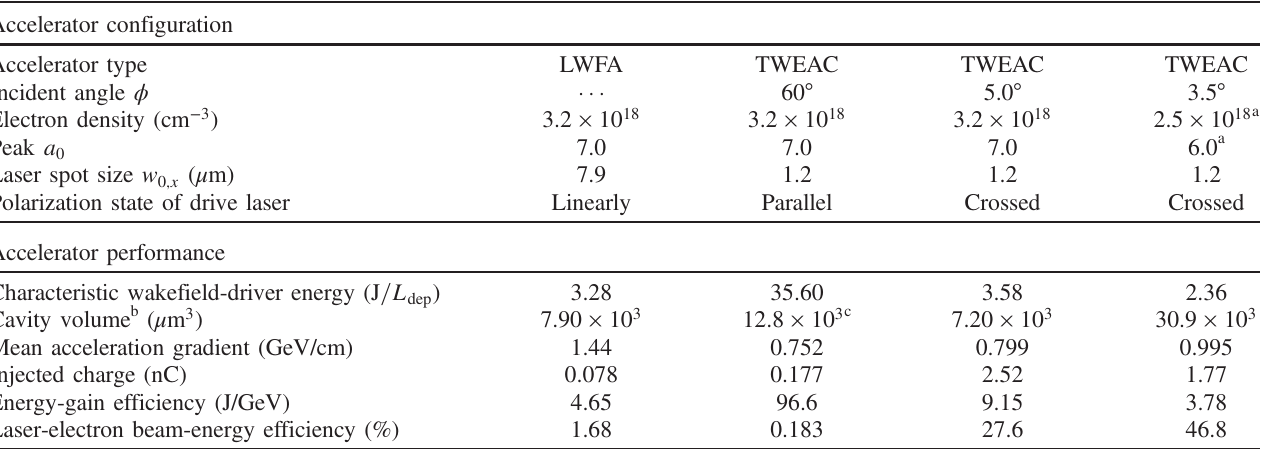
TABLE I. Comparison of various performance and energy efficiency indicators of all LWFA and TWEAC simulations presented. Note is calculated for the LWFA laser pulse length τ 0 ¼ 30 fs at the respective electron that L dep